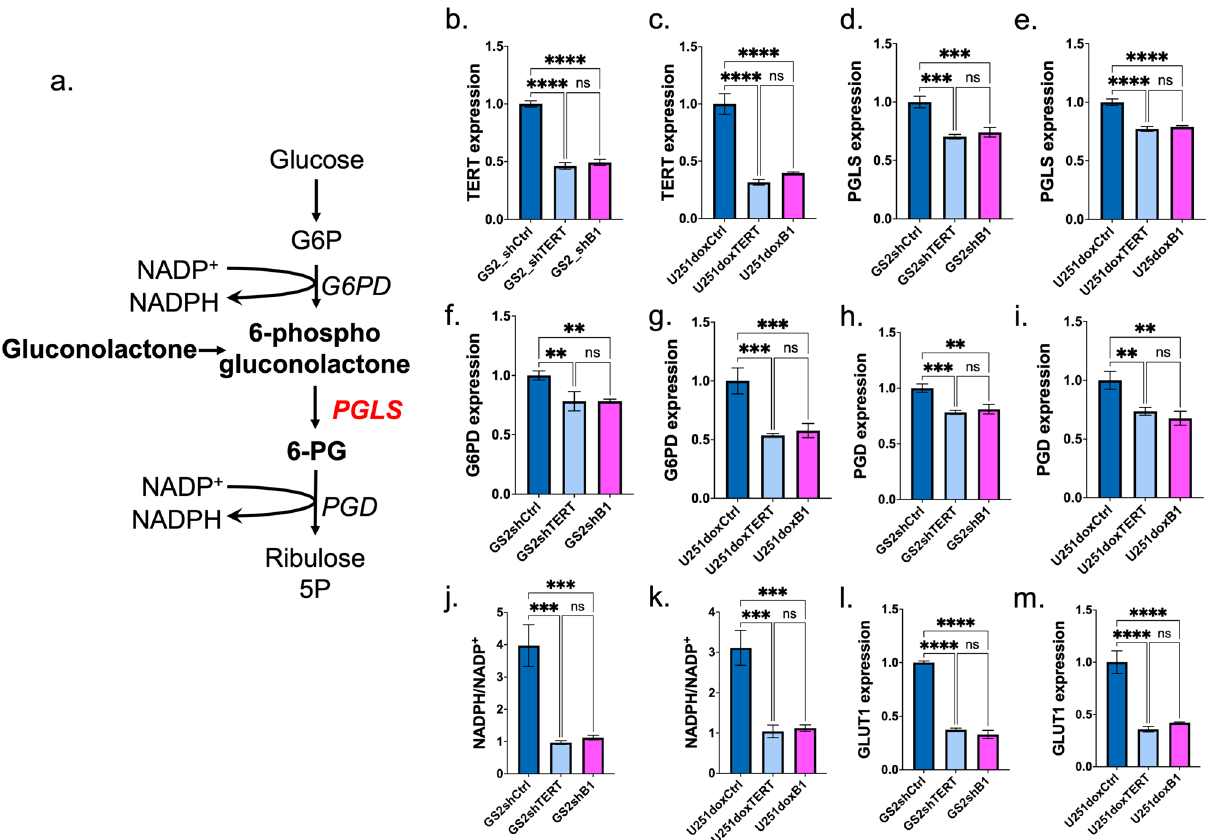
Figure 1. ( a ) Schematic description of pentose phosphate pathway including illustration of the metabolism of gluconolactone and NADPH production. ( b ) TERT expression in GS2shCtrl, GS2shTERT, and GS2shB1. ( c ) TERT expression in U251doxshCtrl, U251doxshTERT, and U251doxshB1. ( d ) PGLS expression in GS2shCtrl, GS2shTERT, and GS2shB1. ( e ) PGLS expression in U251doxshCtrl, U251doxshTERT, and U251doxshB1. ( f ) G6PD expression in GS2shCtrl, GS2shTERT, and GS2shB1. ( g ) G6PD expression in U251doxshCtrl, U251doxshTERT, and U251doxshB1. ( h ) PGD expression in GS2shCtrl, GS2shTERT, and GS2shB1. ( i ) PGD expression in U251doxshCtrl, U251doxshTERT, and U251doxshB1. ( j ) NADPH/NADP + ratio comparing GS2shCtrl, GS2shTERT, and GS2shB1. ( k ) NADPH/NADP + ratio comparing U251doxshCtrl, U251doxshTERT, and U251doxshB1. ( l ) GLUT1 expression in GS2shCtrl, GS2shTERT, and GS2shB1. ( m ) GLUT1 expression in U251doxCtrl, U251doxshTERT, and